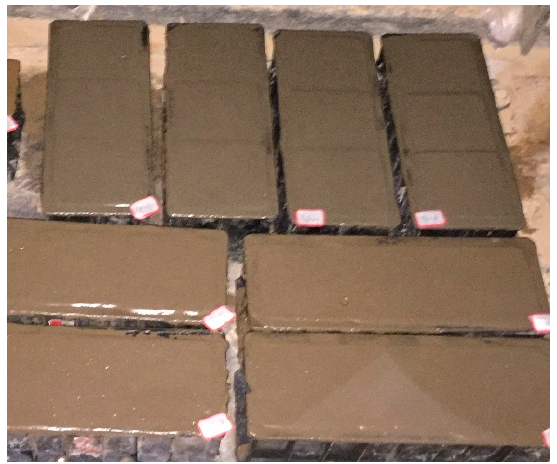
Figure 1. Injection mold for foam lightweight soil.